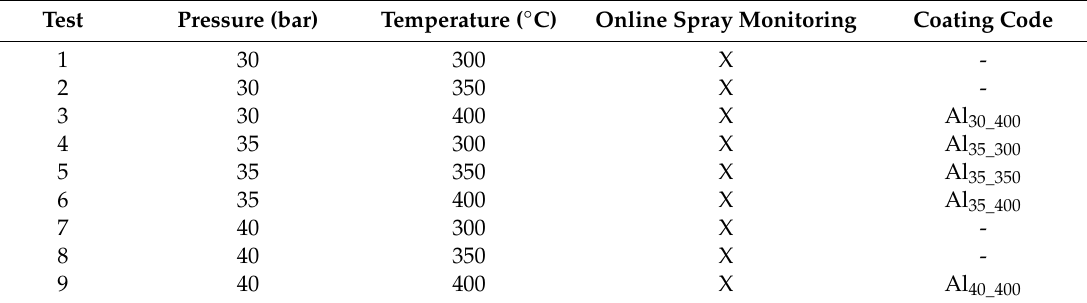
Table 1. Cold spray test conditions and prepared